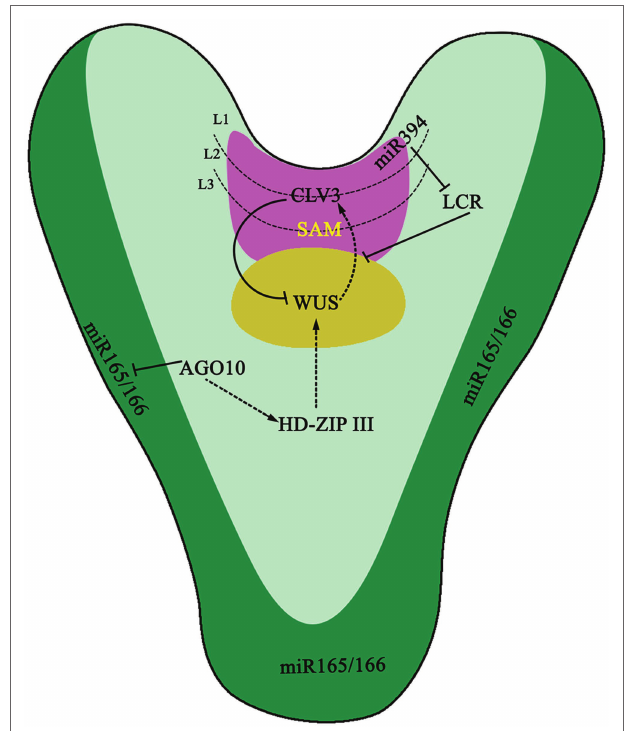
FIGURE 1 | The function of miRNAs in embryo. miR394 expresses in the L1 layer of shoot apical meristem (SAM) and then moves to L3 layer to target Leaf Curling Responsiveness ( LCR ) gene. LCR further regulates CLAVATA- WUSCHEL (CLV-WUS) negative feedback loop for proper SAM development and specification. ARGONAUTE10 (AGO10) specifically sequesters miR166/165 to upregulate Class III homeodomain leucine zipper transcription factors (HD-ZIP III TFs) to maintain SAM development. The dotted arrows represent a proposed positive regulation, whereas lines with perpendicular end bars indicate negative